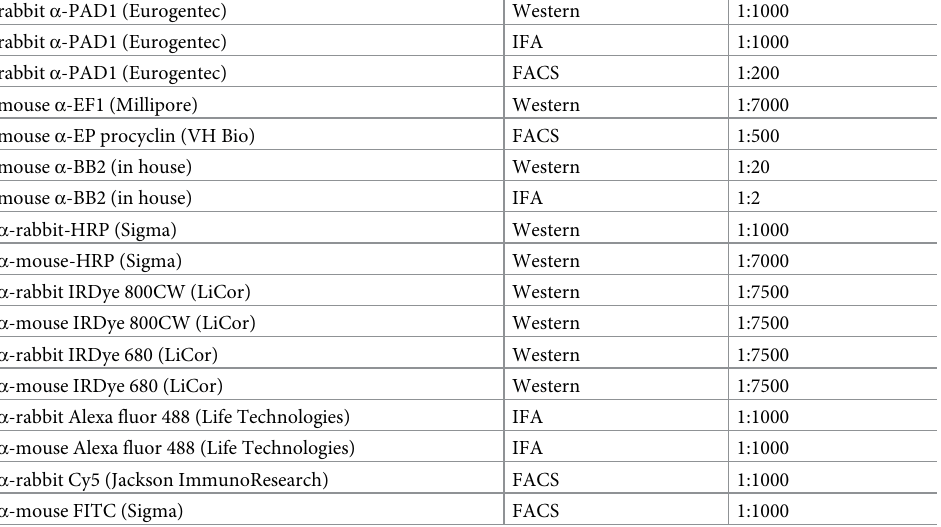
Table 1. Antibodies used in various applications in this